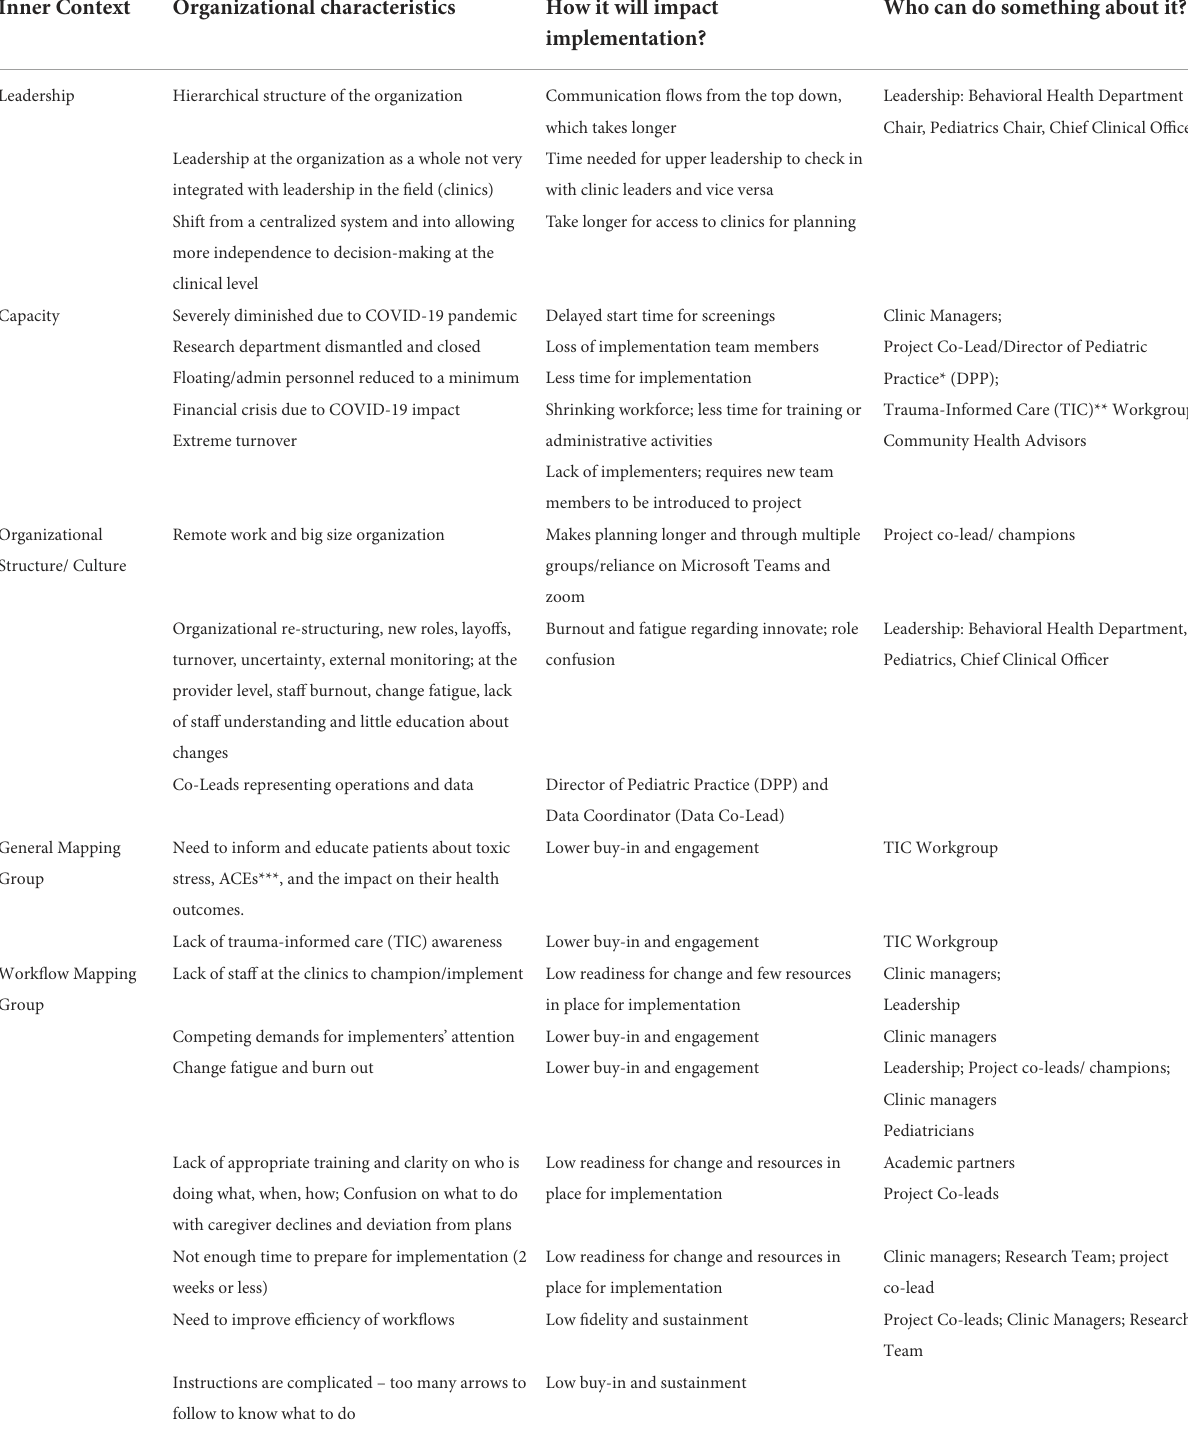
TABLE 1 Implementation Mapping: task